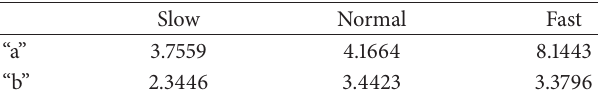
Table 3: Average error of tracking with various velocity conditions (UNIT: pixels).